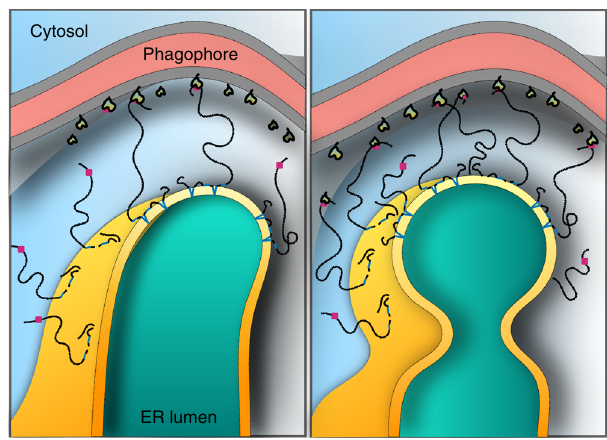
Fig. 8 Role of FAM134B-induced membrane curvature in ER-phagy. FAM134B induces high curvature in the ER membrane